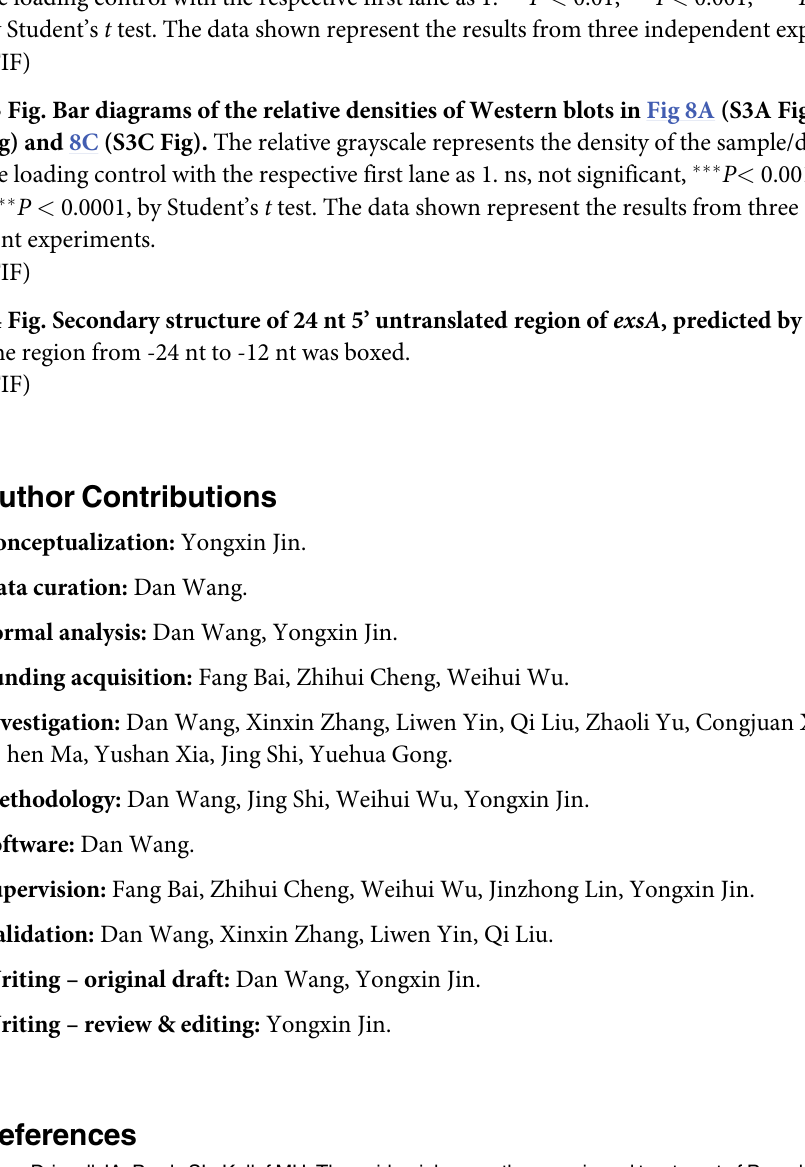
S2 Fig. Bar diagrams of the relative densities of Western blots in Figs 2B (S2A and S2B Fig) and 3E (S2C Fig). The relative grayscale represents the density of the sample/density of the loading control with the respective first lane as 1. �� P < 0.01, ��� P < 0.001, ���� P < 0.0001, by Student’s t test. The data shown represent the results from three independent experiments. S3 Fig. Bar diagrams of the relative densities of Western blots in Fig 8A (S3A Fig), 8B (S3B Fig) and 8C (S3C Fig). The relative grayscale represents the density of the sample/density of the loading control with the respective first lane as 1. ns, not significant, ��� P < 0.001, ���� P < 0.0001, by Student’s t test. The data shown represent the results from three indepen- dent experiments. S4 Fig. Secondary structure of 24 nt 5’ untranslated region of exsA , predicted by Mfold. The region from -24 nt to -12 nt was